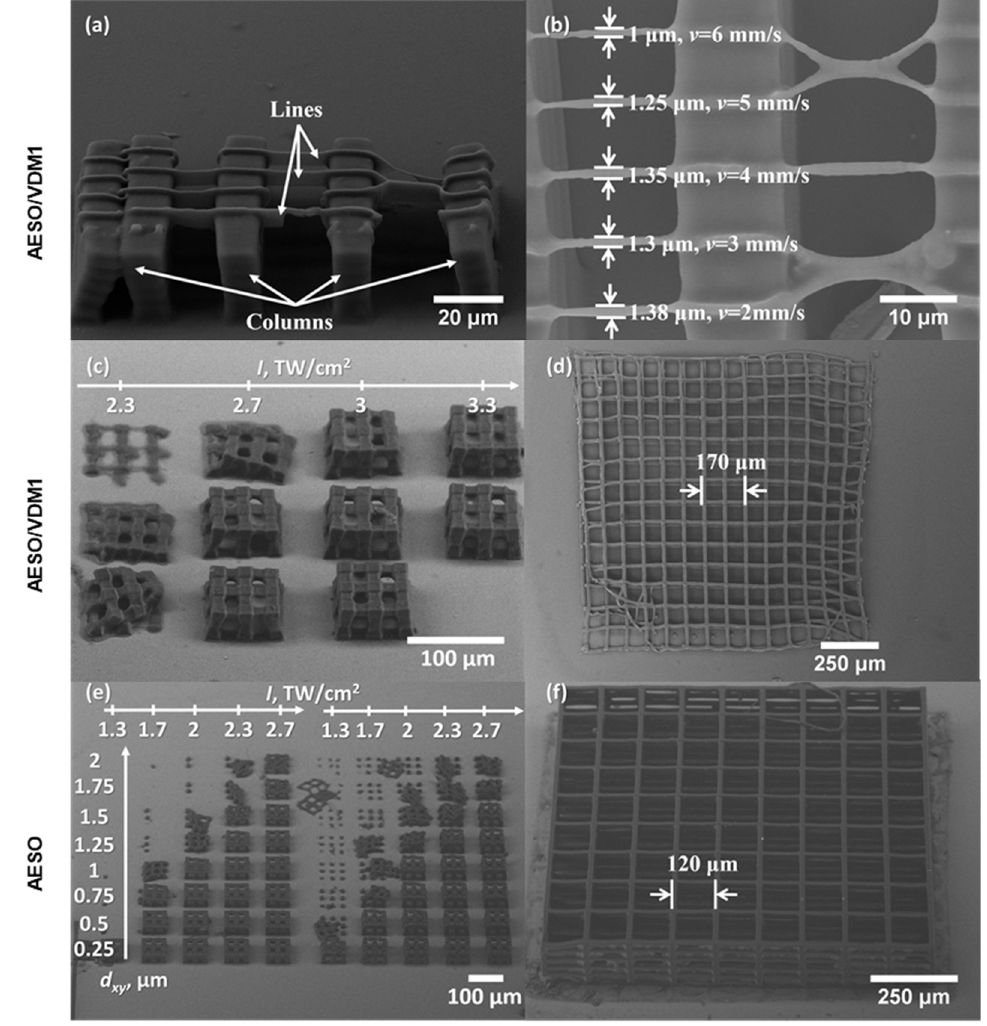
Figure 7. The SEM images of RB and 3D microporous woodpile structures: ( a ) a side view of RB at the angle of 45 degrees and 1800 magnification. The applied power P to produce bridges was 0.6 mW (2 TW/cm 2 ), scan velocity v varied from 0.1 mm/s to 0.5 mm/s every 0.1 mm/s; ( b ) a top view of the other RB at 4000 magnification. P = 0.6 mW (2 TW/cm 2 ) , v = 2–6 mm/s every 1 mm/s; ( c ) 75 × 75 µm 2 woodpile structures with a 30 µm period, v = 5 mm/s, the scale at the top of the image demonstrates the applied I ; ( d ) a 1065 × 1065 µm 2 woodpile with a 75 µm period, v = 5 mm/s, P = 0.4 mW (1.3 TW/cm 2 ). (a–d) The structures were fabricated out of the resin AESO/VDM1; ( e ) 75 × 75 µm 2 woodpile structures with a 30 µm period, v = 5 mm/s. Scale on the left of image shows the distance d xy between neighboring scans; ( f ) a 1095 × 1095 µ m 2 woodpile with 120 µ m period, v = 5 mm/s, P = 0.6 mW (2 TW/cm 2 ). ( e , f ) structures were fabricated out of